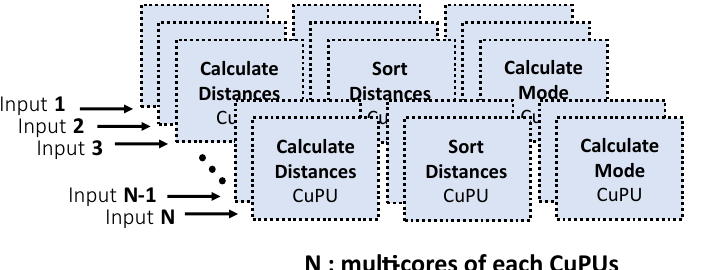
Figure 1. A general architecture for the KNN algorithm using N numbers of CuPUs in